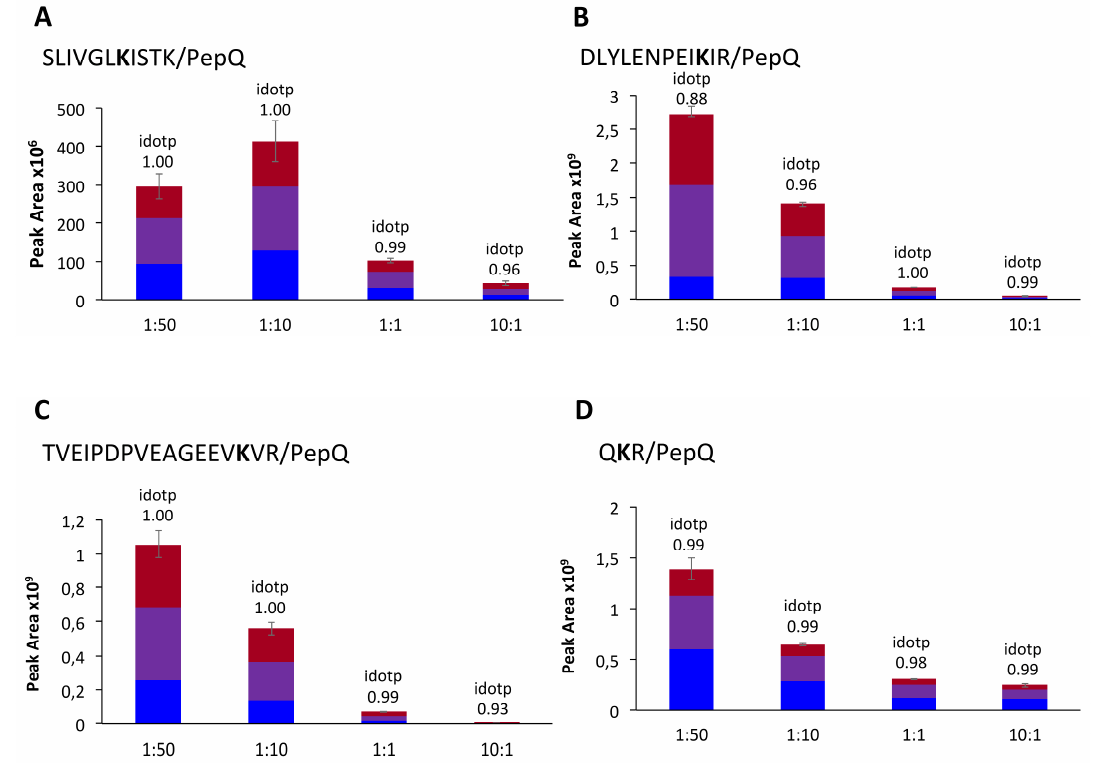
Figure 3. Peak areas of the isopeptides between PepQ and the most preferred TG2 binding sites. The illustration shows the peak areas for the isopeptides ( A ) SLIVGLKISTK / PepQ, ( B ) DLYLENPEIKIR / PepQ, ( C ) TVEIPDPVEAGEEVKVR / PepQ and ( D ) QKR / PepQ in the molar ratios 1:50, 1:10, 1:1, and 10:1, respectively.